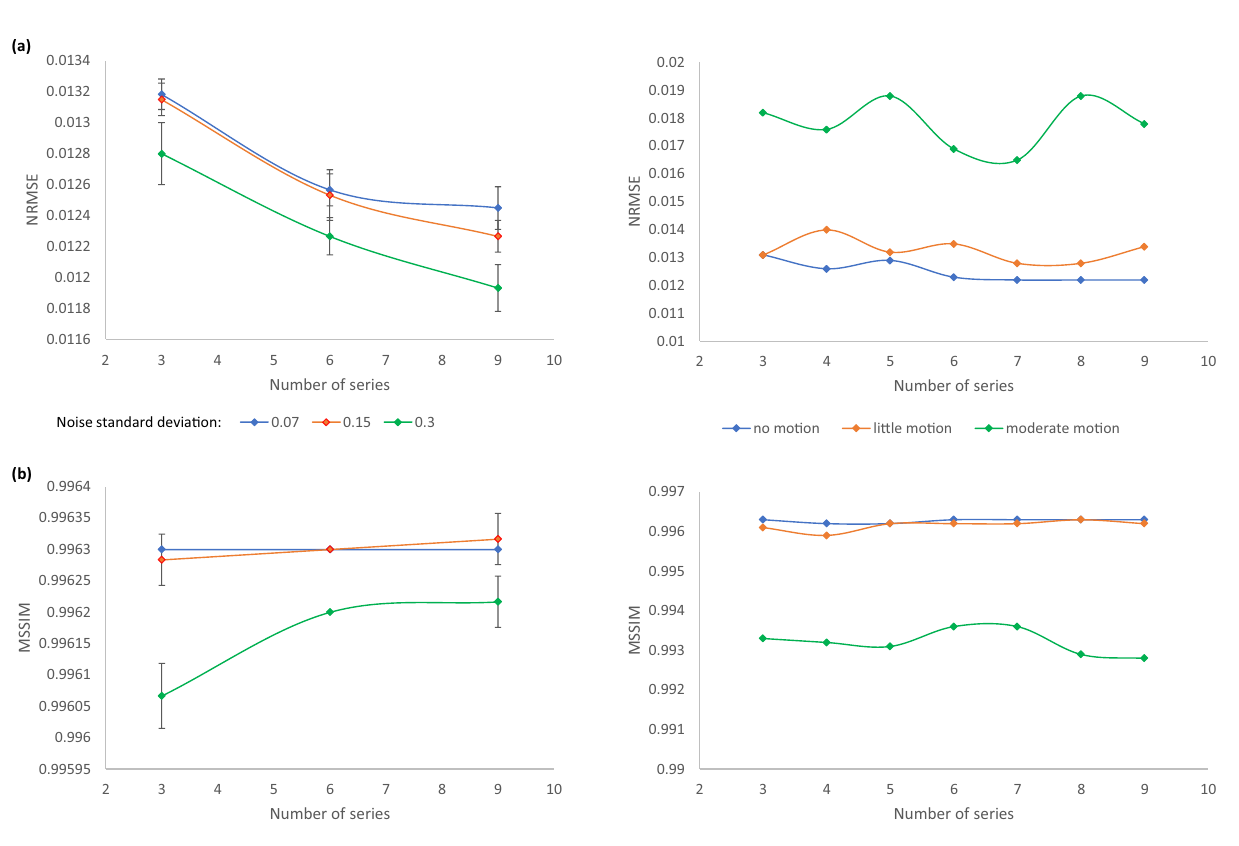
Figure 5. ( a ) Normalized root mean squared error (NRMSE) and ( b ) mean structural similarity index (MSSIM) between SR reconstructions from different numbers of orthogonal LR HASTE series simulated at a GA of 30 weeks and the corresponding static 3D HR ground truth. The left panel shows results for motion-free data with various noise levels, a SD of 0.15 leading to a similar appearance as in clinical acquisitions. The right panel illustrates how the algorithm performs depending on the amplitude of fetal movements in the input